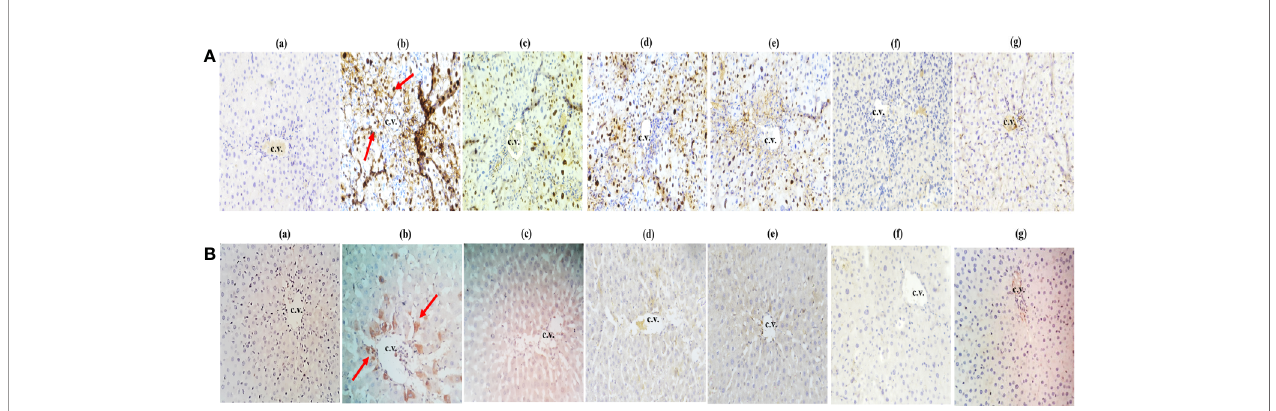
FIGURE 7 | Effect of Obeth from O. bracteata on expression levels of proteins using immunohistochemical analysis of liver tissues. (A) shows cyclin (d) and (B) shows p53 antibodies. Arrows showed the increase in expression of cyclin D and p53 proteins in CCl 4 treated liver samples (Original magni fi cation = 40 x). Expression of these proteins was downregulated when observed in liver samples co-treated with CCl 4 and Obeth (200 mg/kg b.wt.). Red arrow indicates the increase in the expression of protein in the CCl 4 treated group. (b) Control group (tap water ad libitum) (GI) showing normal lobular architecture with clear portal